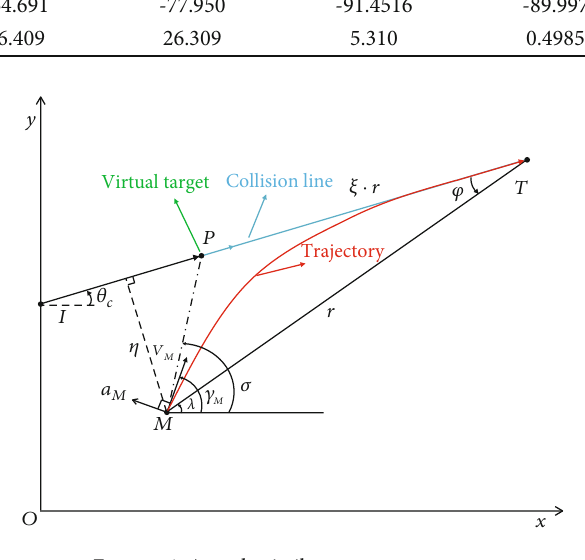
Figure 6: Actual missile target